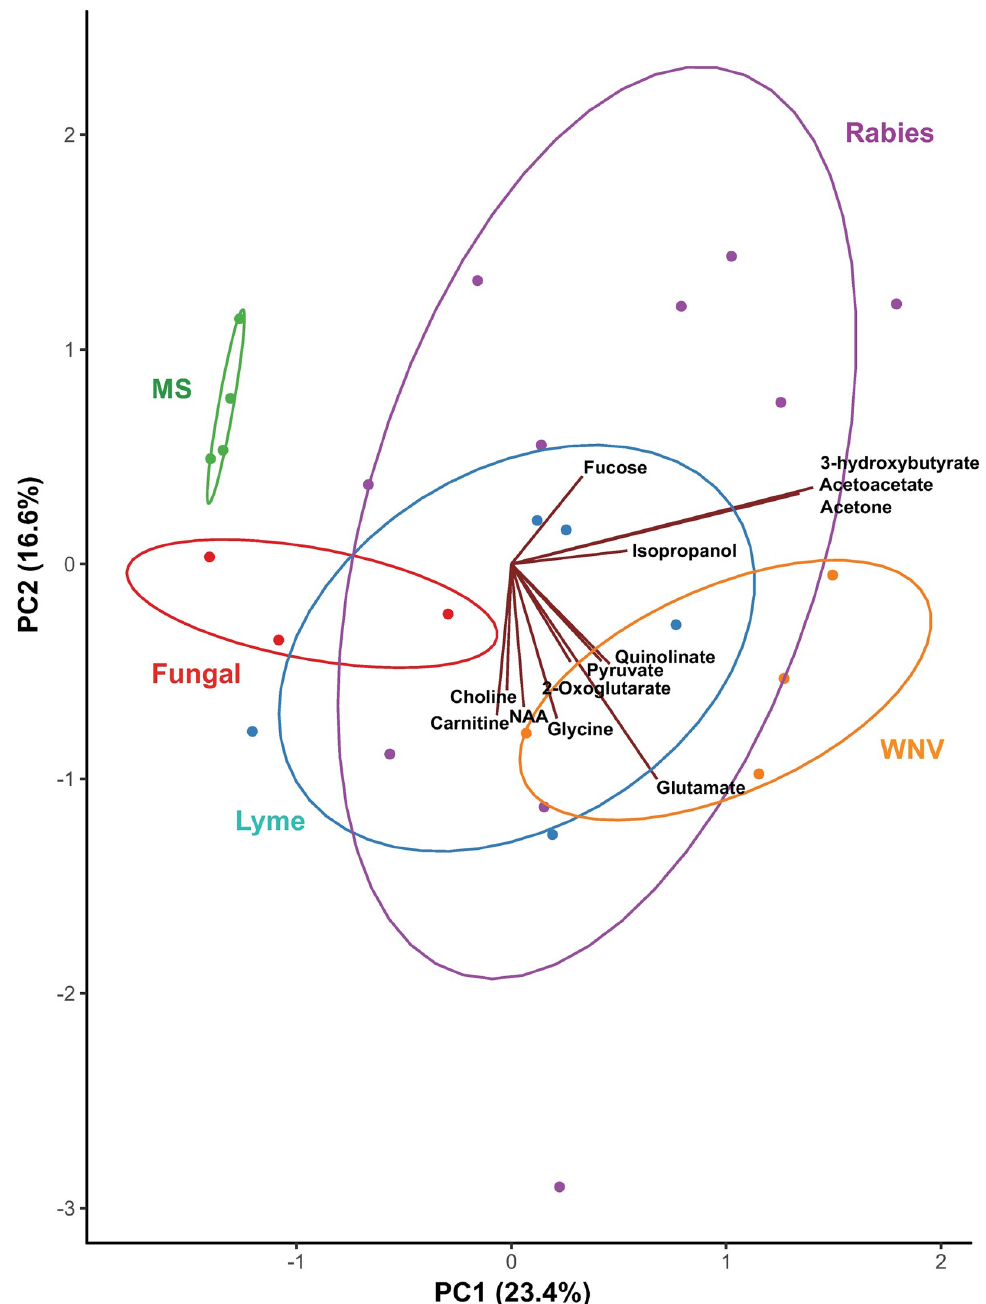
Fig 2. Principal component analysis of 1 H-NMR CSF metabolomic data comparing neurological diseases. Samples were collected from patients with multiple sclerosis (MS, represented in green), fungal infection (red), Lyme disease (blue), West Nile virus (WNV, orange), and rabies (purple). Normal data ellipses are shown for each group. Axes represent principal component (PC) scores. The percent of the variation explained by each component is given in parentheses. Vectors represent loadings of select metabolites with PC1 and PC2, as drawn in the Gabriel’s biplot. Groups of vectors that point in similar directions tend to change together. One extreme observation was excluded.